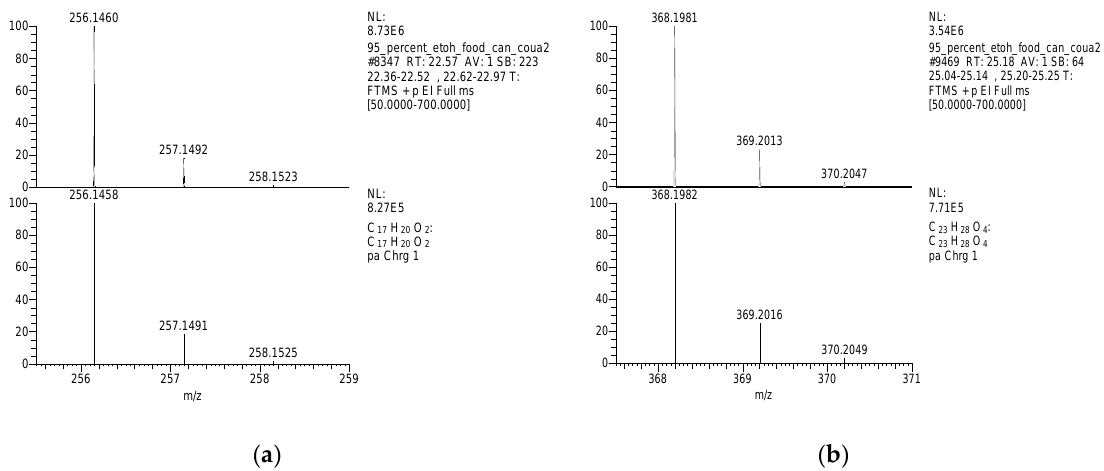
Figure 2. Isotopic pattern comparisons of molecular ions (Top) and theoretical molecular ions ( a ) TMBPF; ( b ) TMBPF (Bottom). ( a ) TMBPF; ( b ) TMBPF DGE.